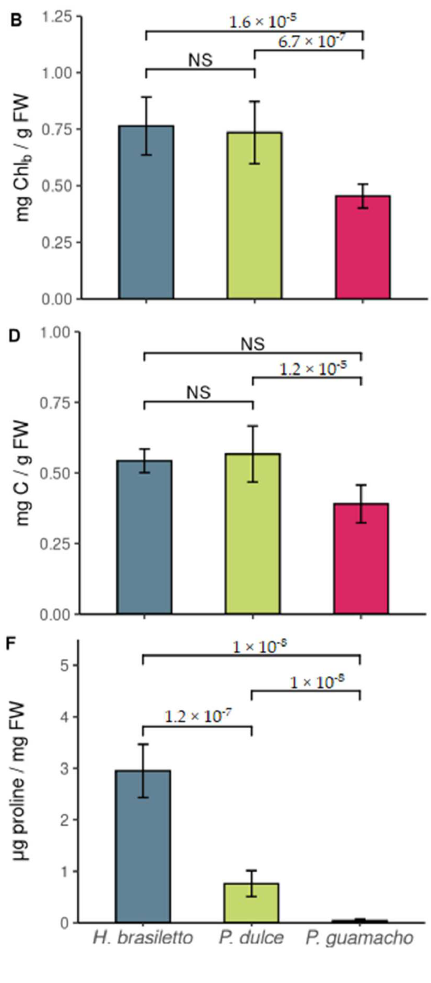
Figure 2. The fast fluorescence rise (measured with the PEA instrument) in H. brasiletto, P. dulce , and P. guamacho leaves. Transient curves of each line represent the average of 7 plants.